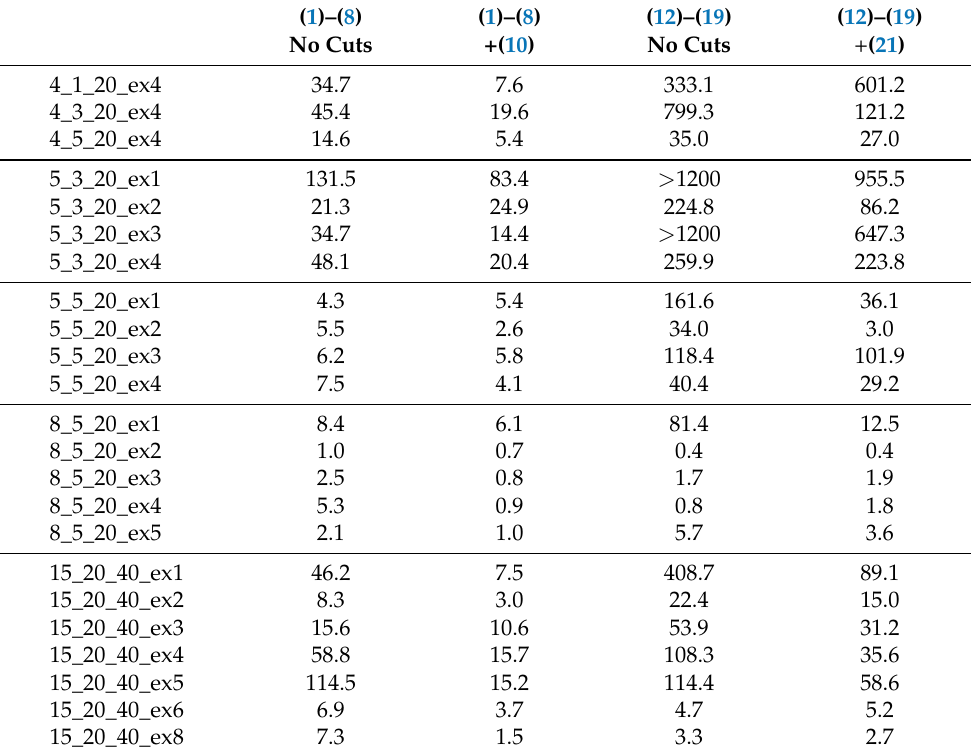
Table 3. Comparison of computation time (in seconds) of both compact MILP formulations of Section 3, with or without the 2-sub-tour